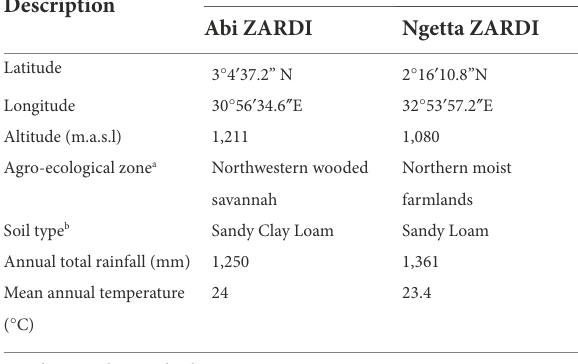
TABLE 2 Description of field study